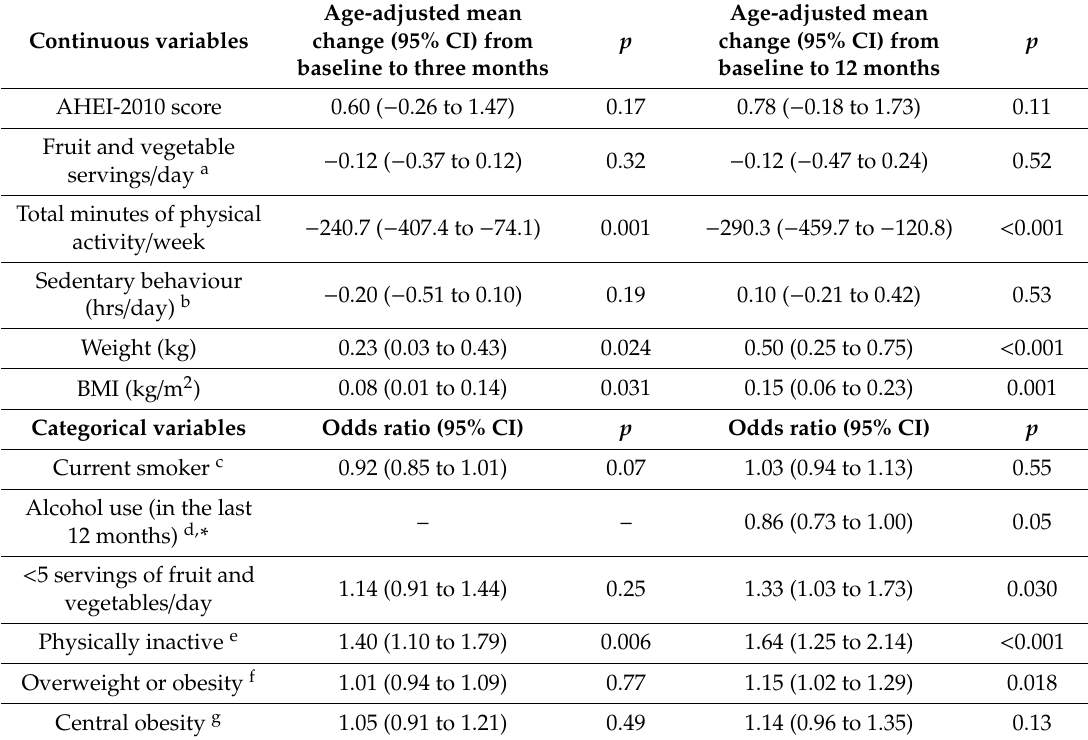
Table 3. Age-adjusted changes in behavioural and clinical risk factors for NCDs from baseline to three and 12